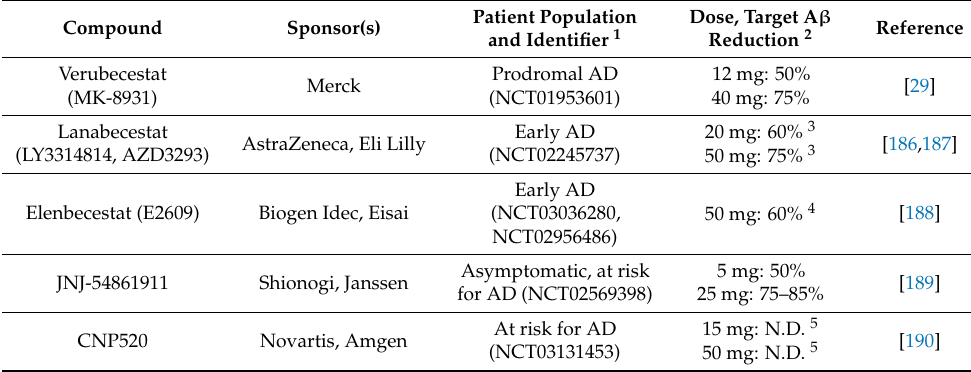
Table 4. Target A β reduction for BACE1 inhibitors currently in Phase 3 clinical trials for